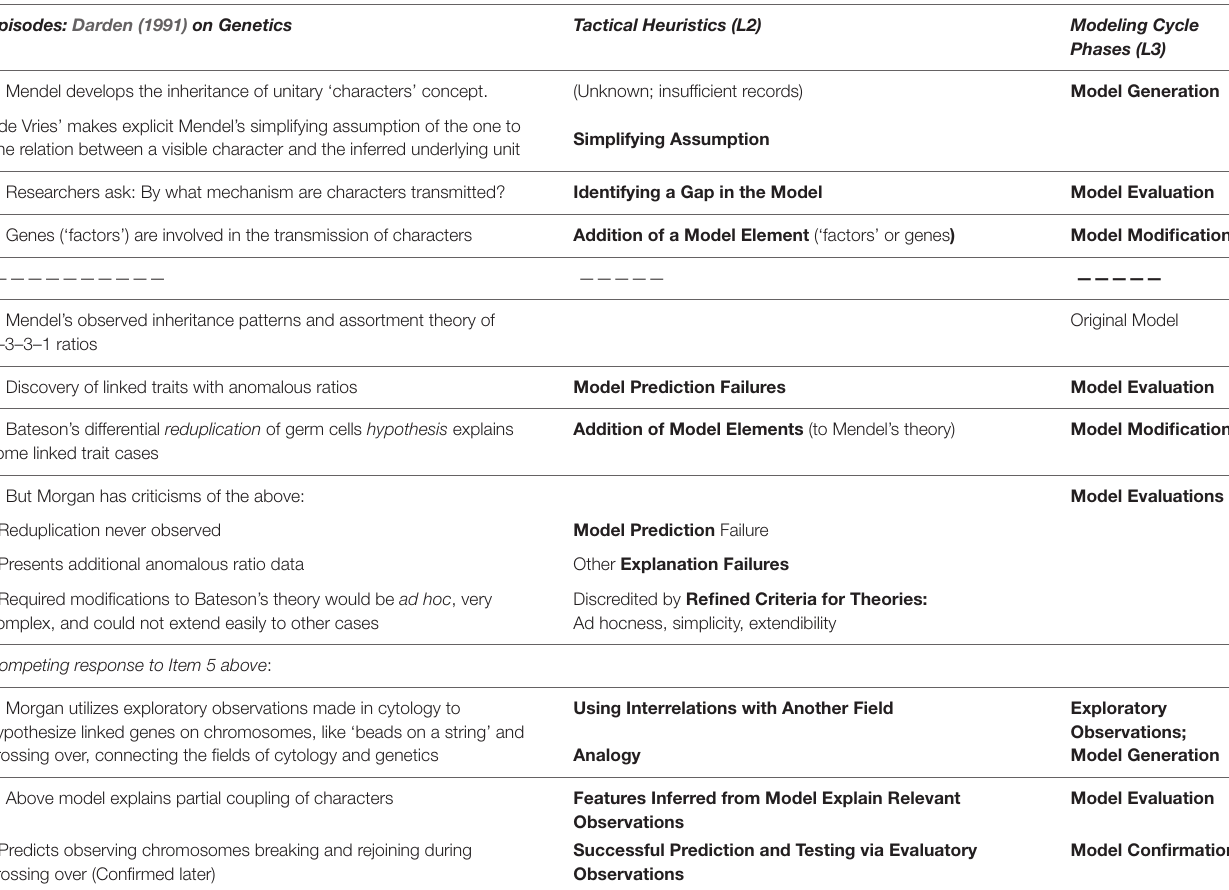
TABLE 1 | Examples of strategies used in the development of genetics. Episodes: Darden (1991) on